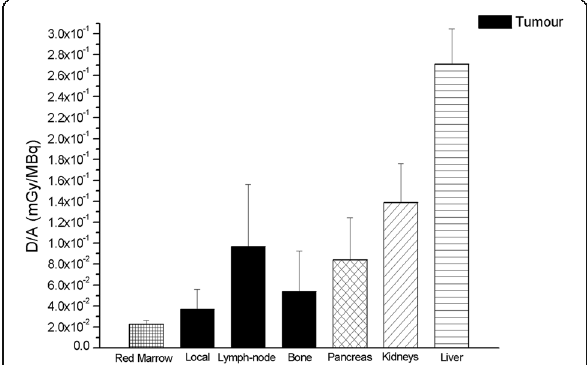
Fig. 6 Absorbed dose per administrated activity in PCa lesions (for each site of disease), red marrow, pancreas, kidneys and